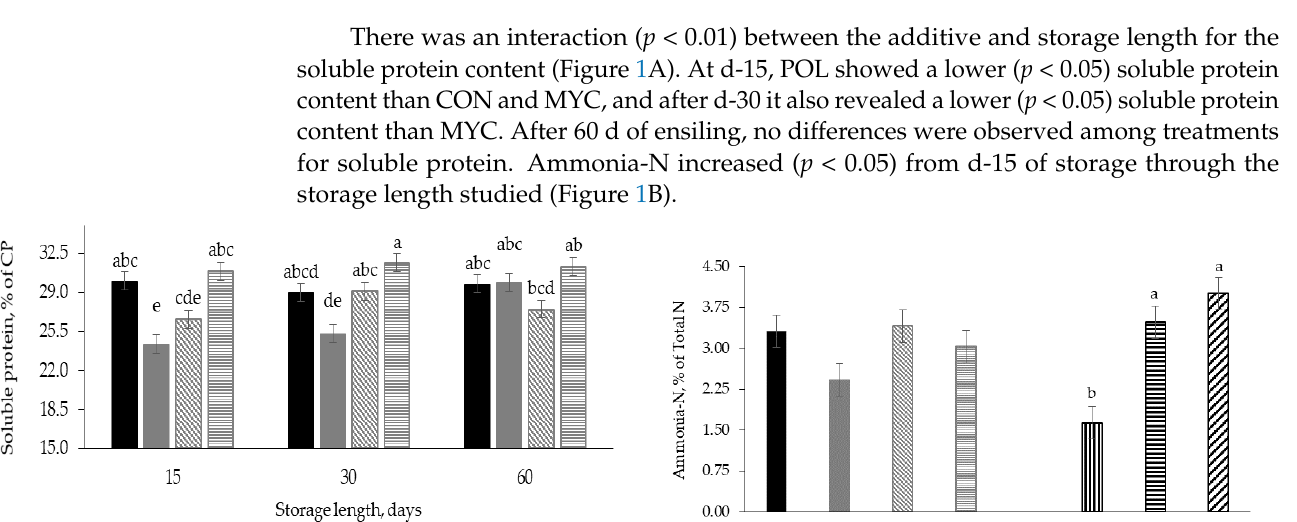
1 Oven dry matter content; 2 Crude protein; 3 Effect of additive (A), storage length (S), and the inter- action between additive and storage length (A × S). a – c Rows with different letters differ by Tukey’s test ( p ≤ 0.05).